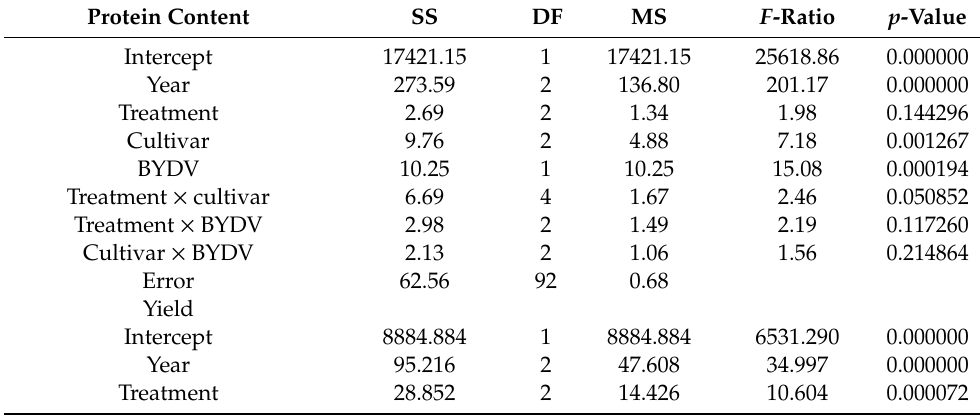
Table 4. Results of analyses of variance (F-value) for protein content, yield, and test